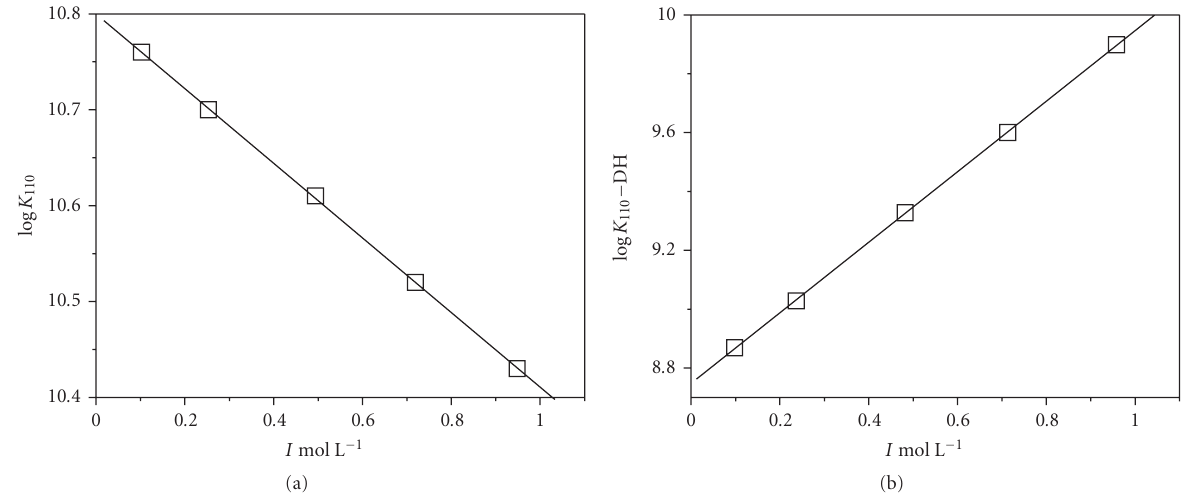
Figure 3: Dependence of stability constants of ( dmt )( en ) 2+ (as log K 110 ) and ( dmt )( asp ) (as log K 110 − DH) species on ionic strength (in mol L − 1 ), in NaCl aq at t = 25 ◦